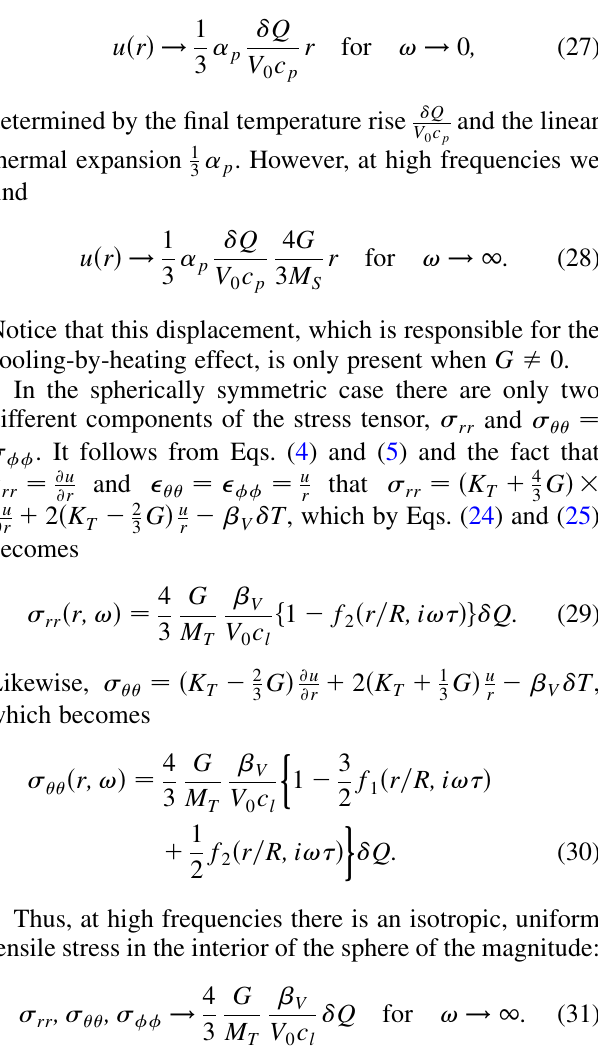
FIG. 2. The real part of the ratio between the complex ampli- tudes of temperature at the center and the heat supplied at the surface scaled with the isobaric heat capacity. At high frequen- cies the limit becomes the negative value (cid:2) a =c 1 (cid:2) c p l